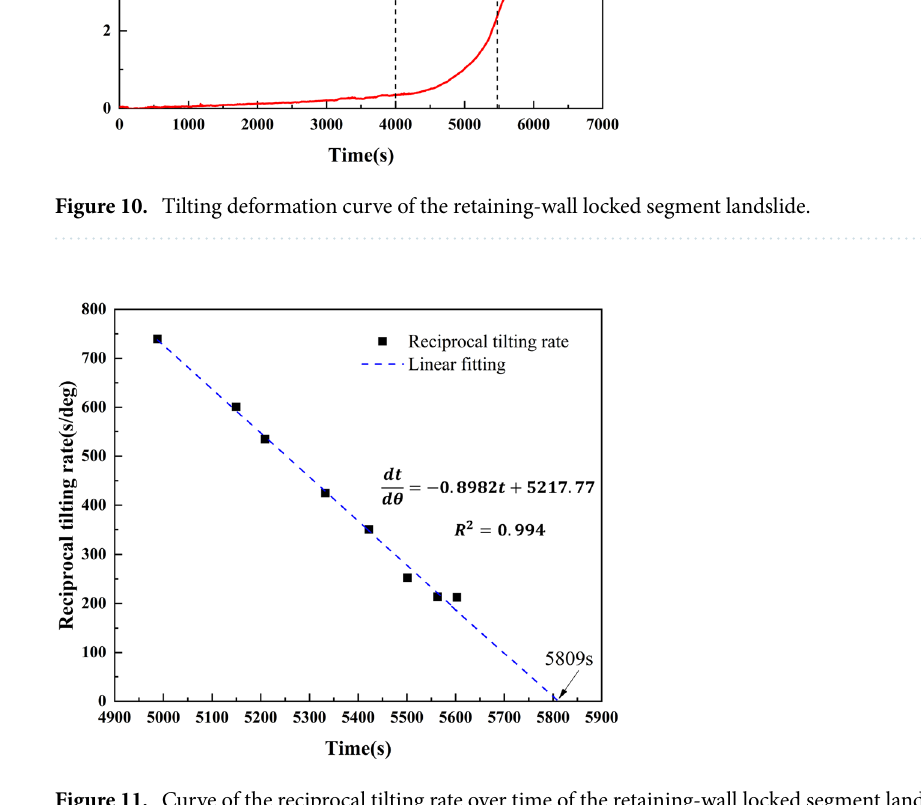
Figure 11. Curve of the reciprocal tilting rate over time of the retaining-wall locked segment